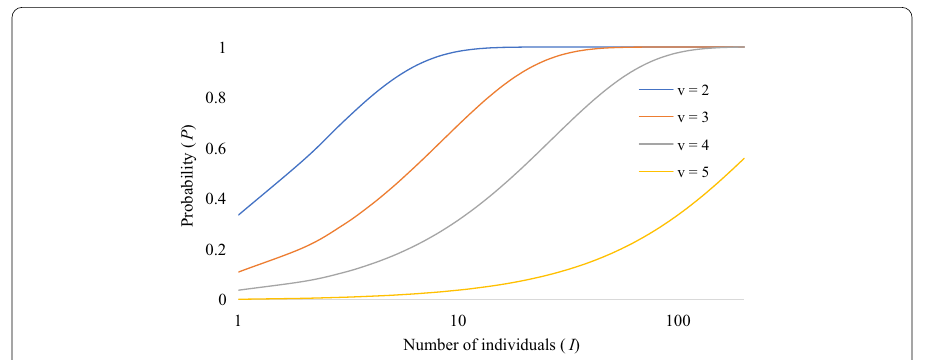
Fig. 5 Given s 3, the probability of grouping interacting features is increasing with respect to the = increasing number of individuals I for v 2, 3, 4, 5 interacting features =